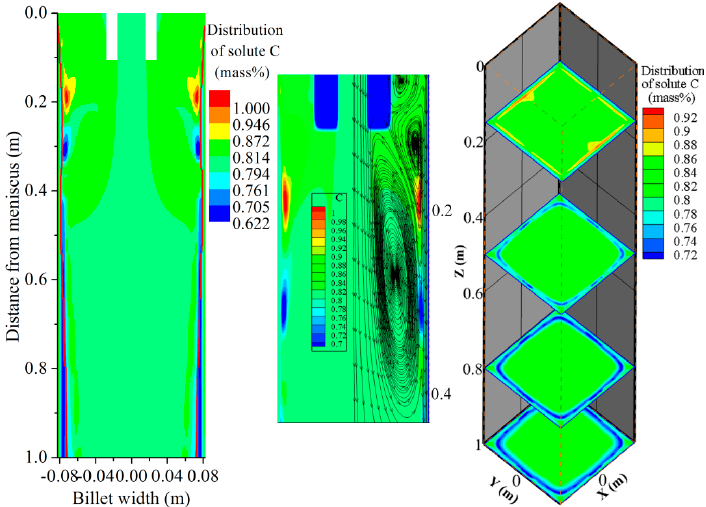
Figure 8. Detailed distribution of solute C in the mold.